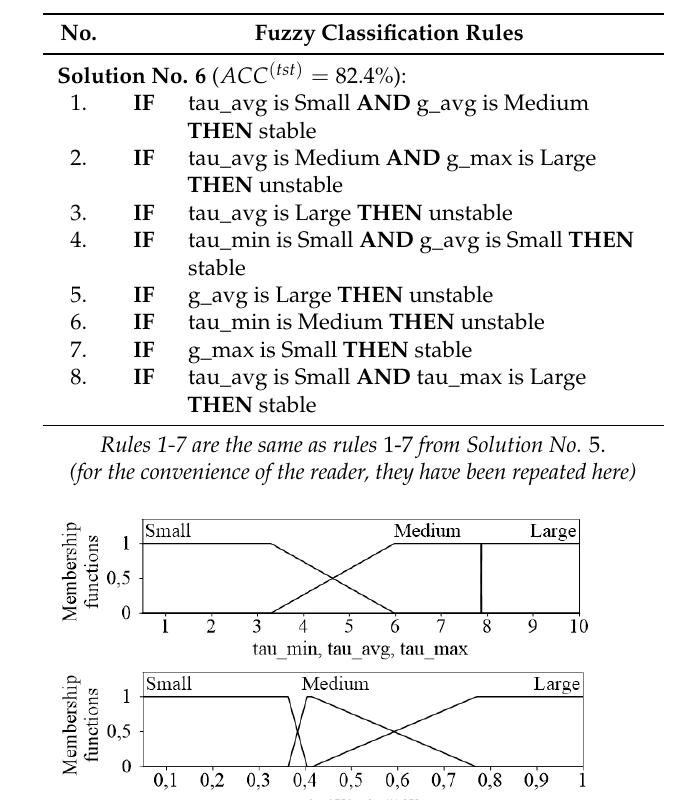
Table 9. Fuzzy rule base for SPEA3-based solution (FRBC) 6 from Figure